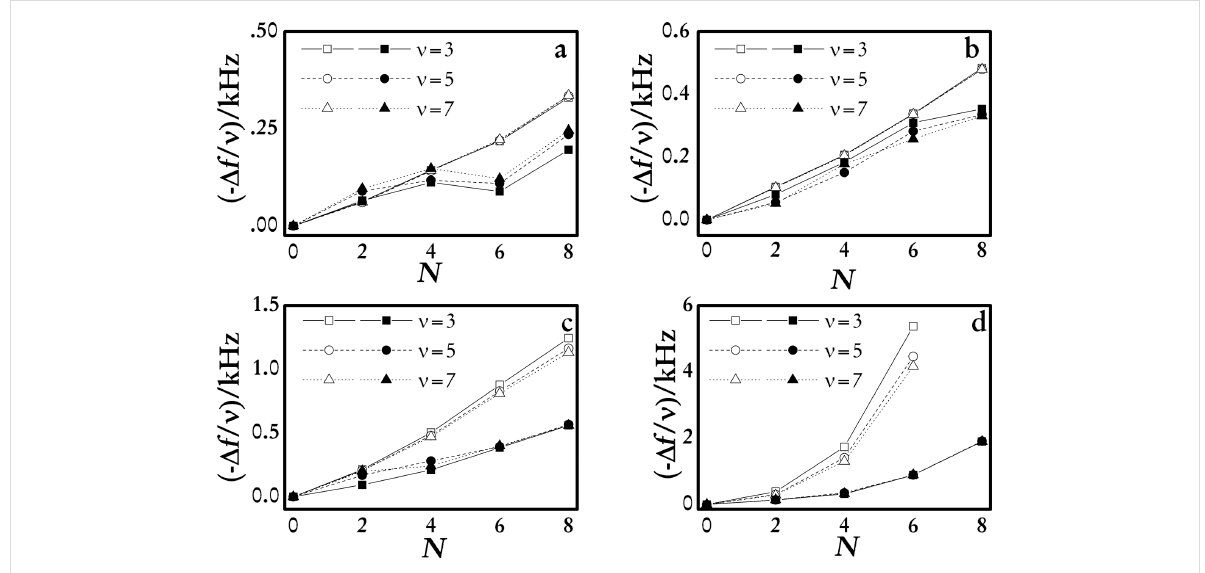
Figure 1: The reduced frequency of the quartz crystal for the different overtones measured (overtones ν = 3, 5 and 7) as a function of N for multi- layers (PDADMAC + PSS) N formed from solutions with different ionic strength. (a) 0.05 M (b) 0.10 M (c) 0.30 M (d) 1.00 M. In all the plots: Wet multi- layers (open symbols) and dry multilayers (solid symbols).